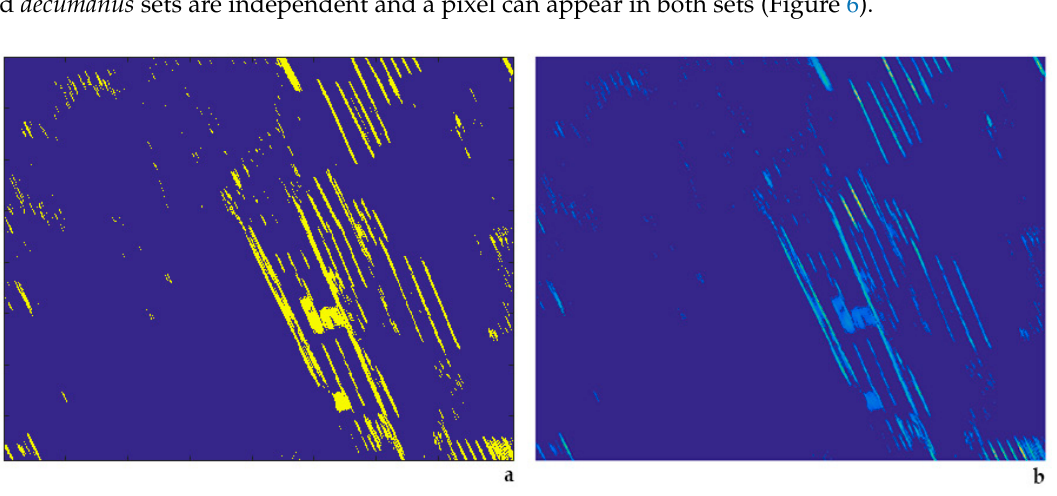
Figure 6. ( a ) Image-mask of the points at the location analyzed in Figure 5 that pass the directional thresholding process described in Section 2.2.1. ( b ) The accumulated filter-responses for those points.